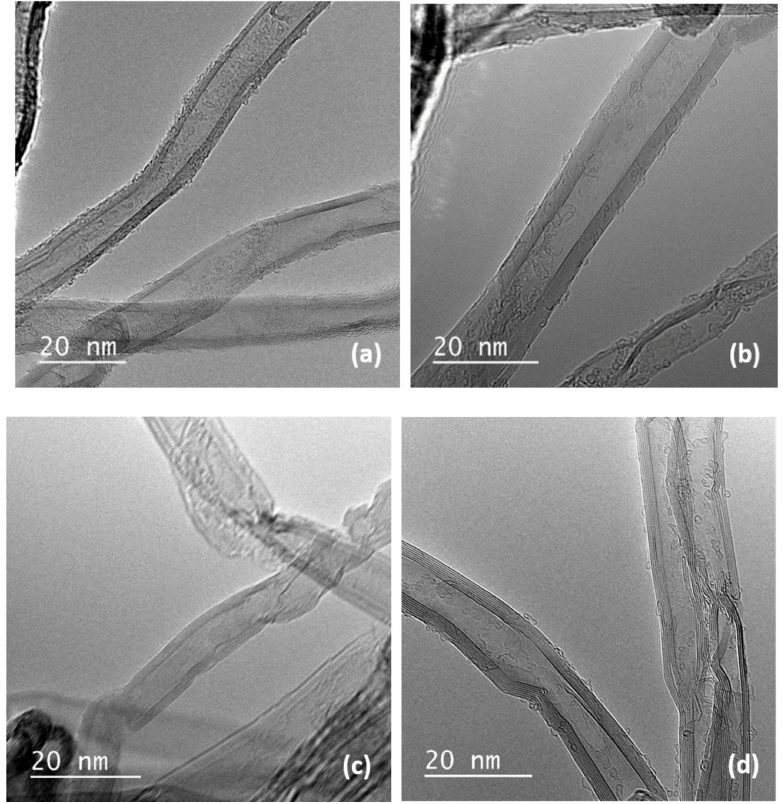
Figure 3. TEM images of MWCNTs: native ( a ) and brominated for 7 ( b ), 10 ( c ) and 14 days ( d